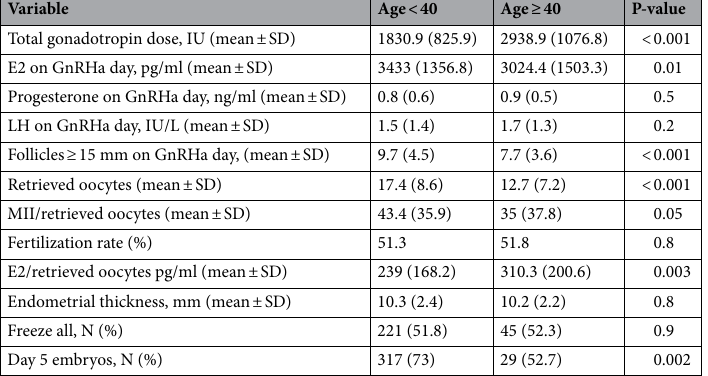
Table 2. Ovarian stimulation parameters. E2 estradiol, GnRHa GnRH agonist, LH luteinizing hormone.